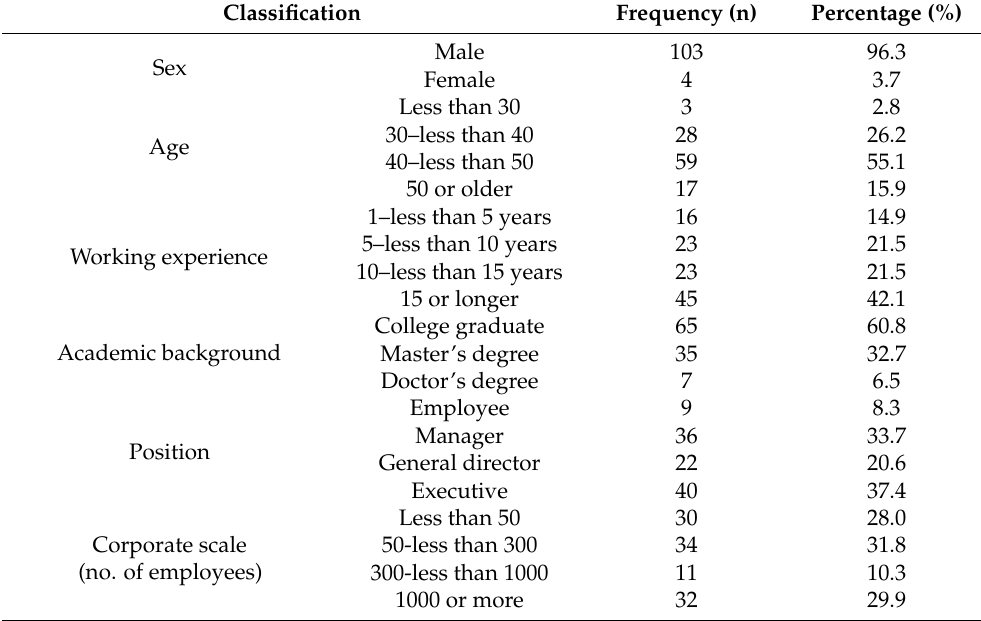
Table 2. Demographic information of survey